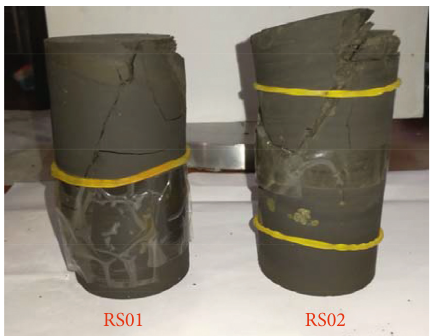
Figure 3: Failure specimens after the test.